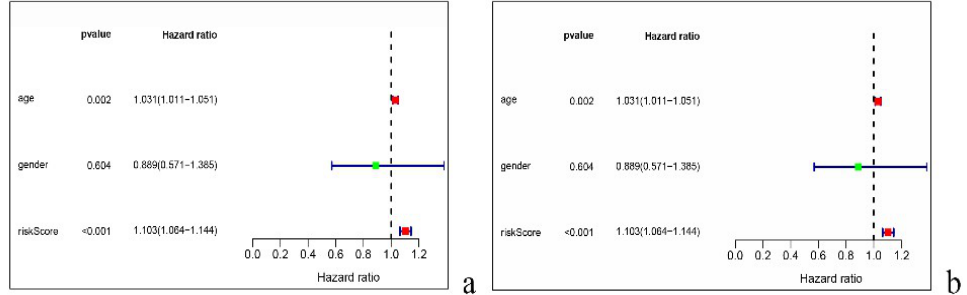
Figure 5. Both the age and risk score can be taken as independent predictors according to the univariate ( a ) and multivariate analyses ( b ).